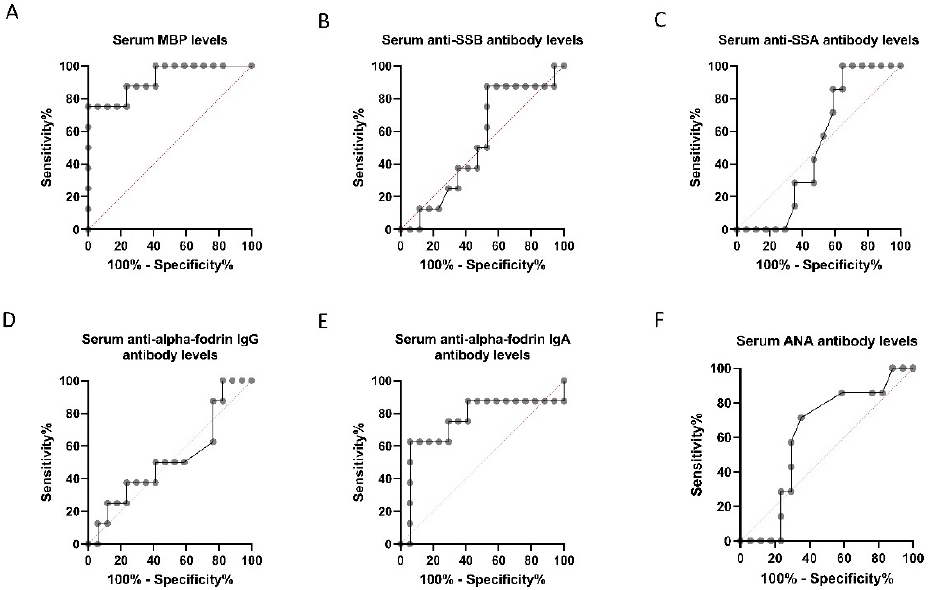
Figure 6. Receiver operating characteristic (ROC) curve plot for discrimination between control and high-tension glaucoma (HTG) patients. ROC curves for serum and myelin basic protein (MBP) concentration ( A ), anti-Sjögren’s-syndrome-related antigen B (SSB) antibody level ( B ), anti-Sjögren’s-syndrome-related antigen A (SSA) antibody level ( C ), anti- α -fodrin IgG/IgA antibody level ( D , E ) and ANA level ( F ) are shown. The area under the curve for the serum MBP antibody level was the largest.